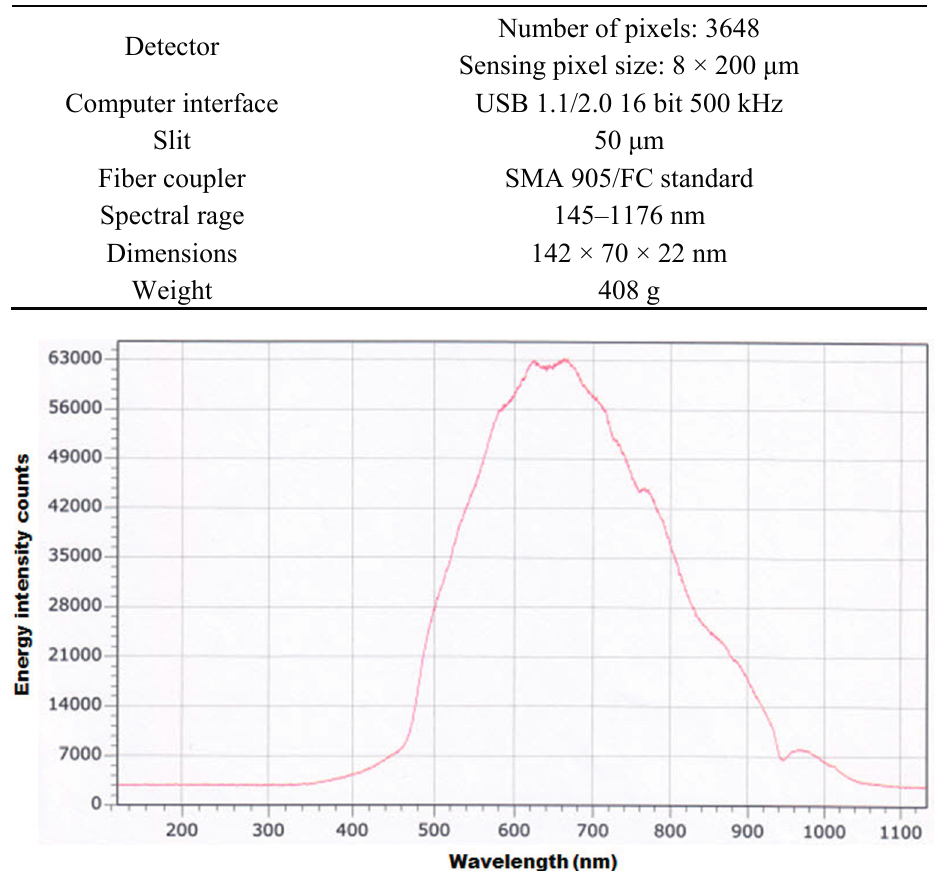
Figure 3. A photograph of the charged-couple device (CCD) linear image sensor ( a ) and spectrometer ( b ) used for measuring the spectrum of red-pepper powder. Table 1. Specifications of the CCD image sensor.